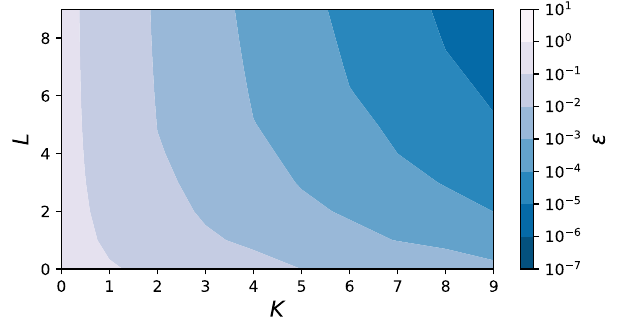
FIG. 8. Illustration of the error term ε in Theorem 1. The error ε decreases exponentially for Selesnick ’ s construction as the parameters K and L are